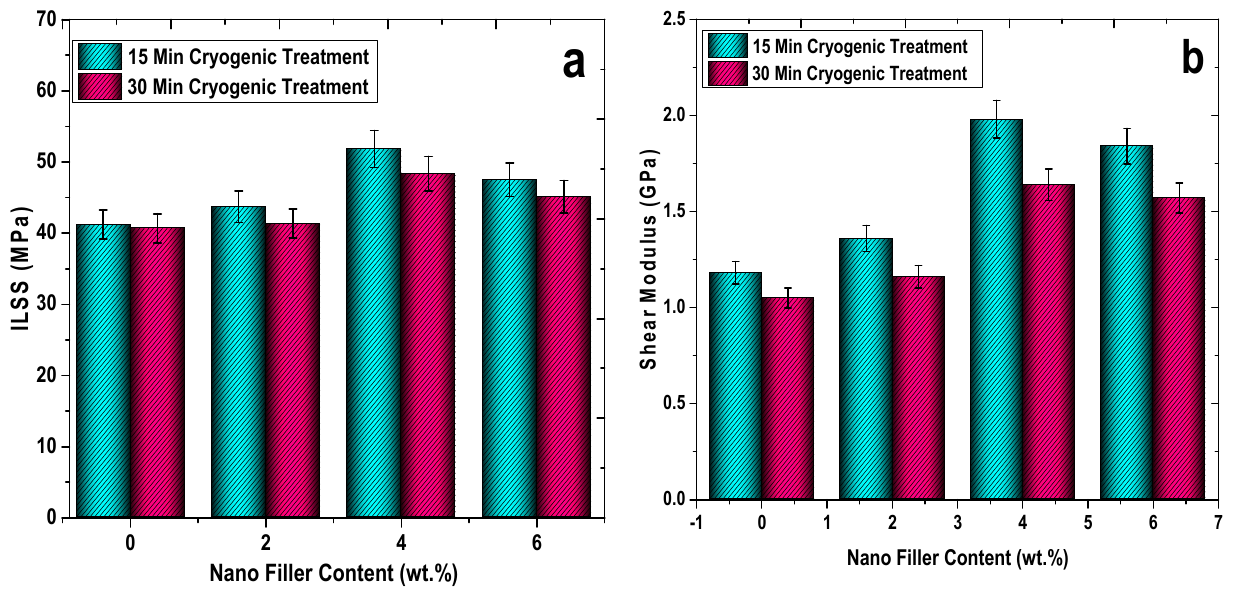
Figure 6. The ILSS and shear modulus of the flax/OPS nanofiller/epoxy based hybrid composites under cryogenic conditions. ( a ) Nano filler content vs ILSS; ( b ) Nano filler content vs shear modulus.